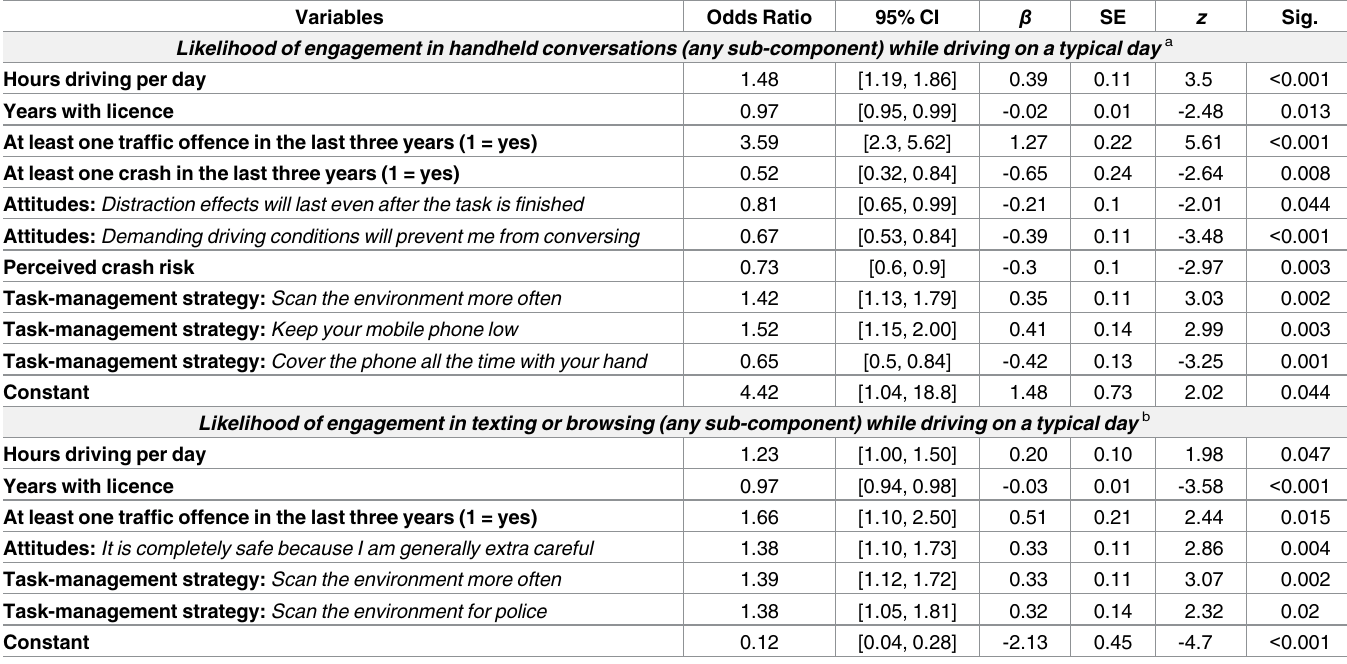
Table 5. Logistic regression analysis: Predicting handheld conversations and texting/browsing